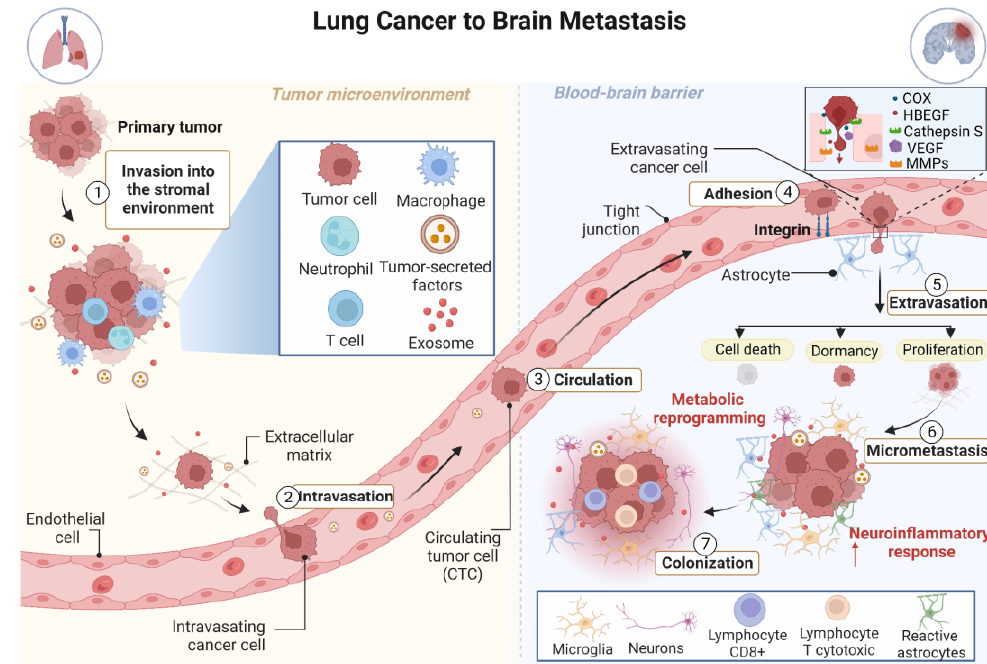
Figure 1. Schematic illustration of brain metastasis development through hematogenous dissemination. Initially, tumor cells at the primary site acquire invasive properties, break away from the primary tumor, and invade the surrounding tissues (intravasation) becoming circulating tumor cells (CTCs). Cell motility is promoted through the interaction between tumor cells and immune cells. Then, CTCs spread throughout the circulatory system to the brain microvasculature (circulation) and after their adhesion with help of integrins, they start the extravasation across the blood – brain barrier (BBB). Tumor cells overexpress enzymes associated with mitogenesis, growth factors, metalloproteinases, and proteases allowing cell migration through the BBB. Once tumor cells are located in the central nervous system (CNS), an intense neuroinflammatory response is triggered. After extravasating, most tumor cells die or enter a state of dormancy (some of them could stay dormant at metastatic sites for long periods). Few tumor cells are able to proliferate within this new microenvironment and then form micrometastases and colonize the brain (colonization). The interaction between tumor cells and immune cells residing in the brain is critical for the establishment and growth of the tumor. COX2: prostaglandin-endoperoxide synthase 2; HBEGF: heparin-binding EGF-like growth factor; MMPs: metalloproteinases; VEGF: vascular endothelial growth